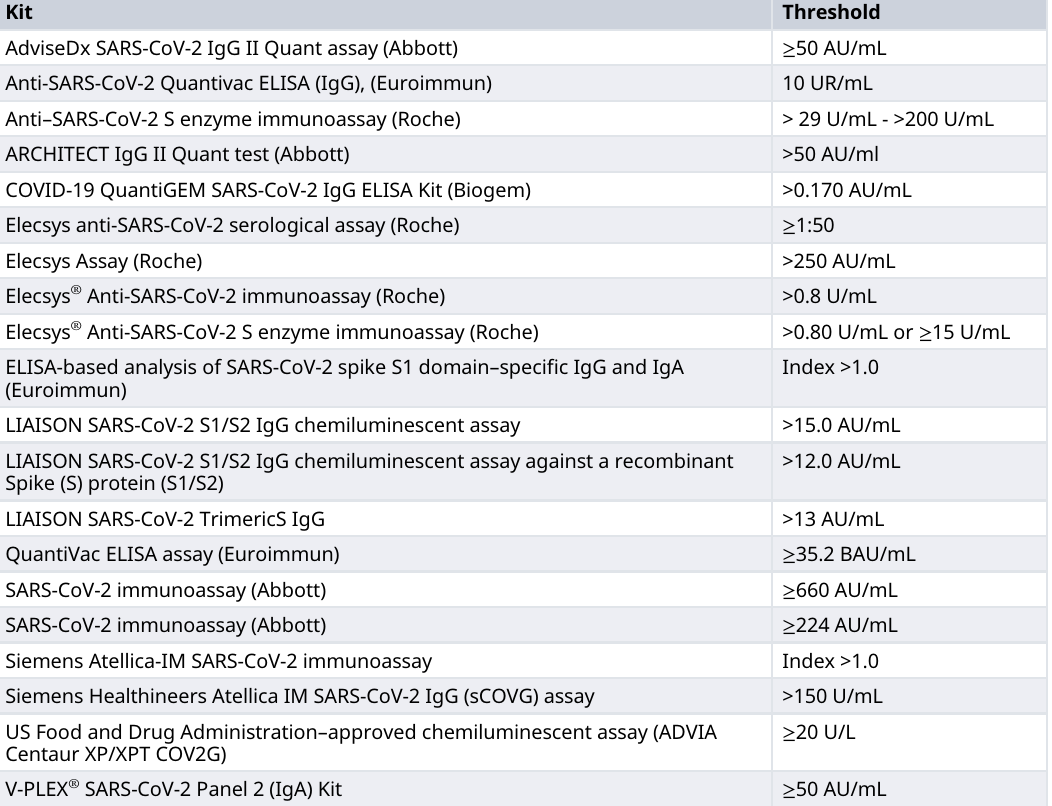
Table 1. An overview of the commercially available kits used to assess seroconversion against COVID-19 and the thresholds that deem an individual seropositive per kit.